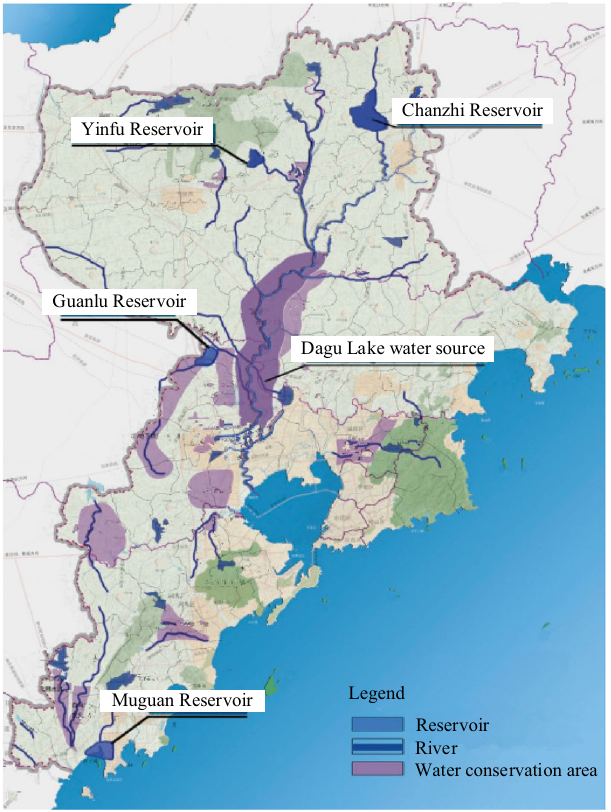
Figure 6. Distribution of water resources in Qingdao (the figure shows the distribution of reservoirs, rivers and water conservation areas in